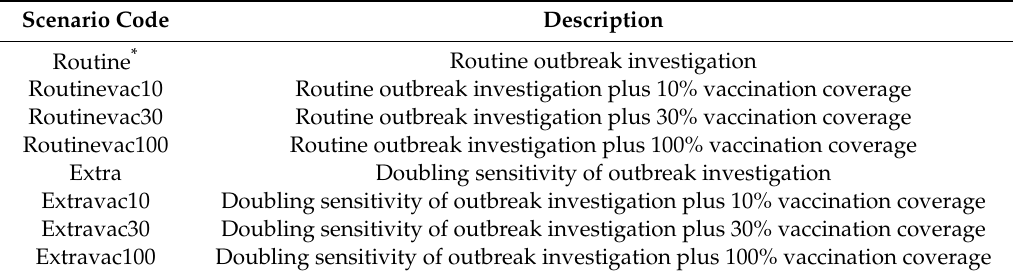
Table 4. Scenarios of